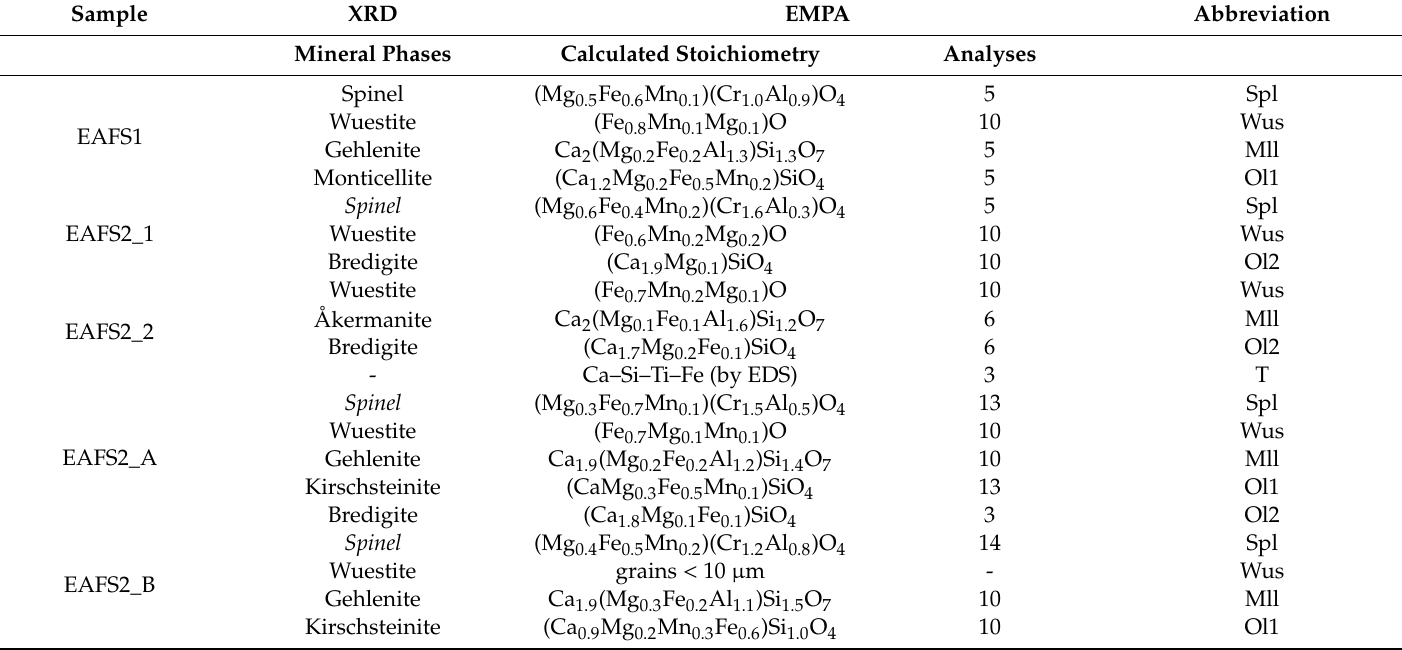
Table 2. Mineral phases (determined by XRD) and calculated mean stoichiometric composition of the measured phases (from the EMP analyses) of the investigated EAF slag samples. All Fe and Mn were calculated as Fe 2 + and Mn 2 + . Italics indicate phases with very low signal in the di ff